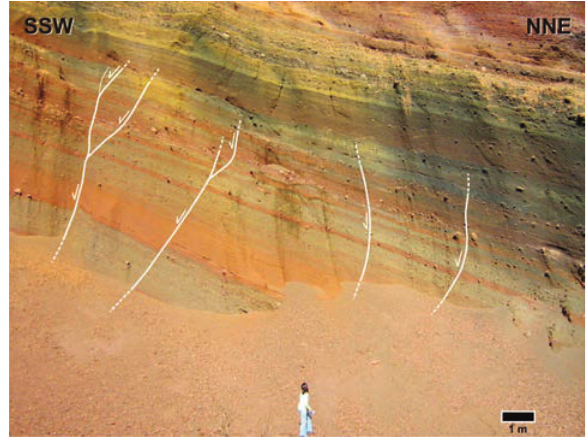
Figure 8. Small faults exposed on wall of a quarry exploiting lapilli from a cinder cone. White arrows specify the dip slip-vector.